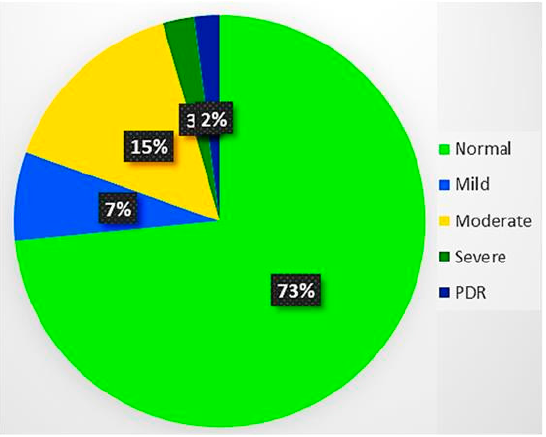
Figure 3. Dataset distribution over DR severity. There were about 73% of images in the normal category, while only 2% of them from the proliferative DR category. Thus, it was an imbalanced dataset with 36: 1 for normal and proliferative DR.